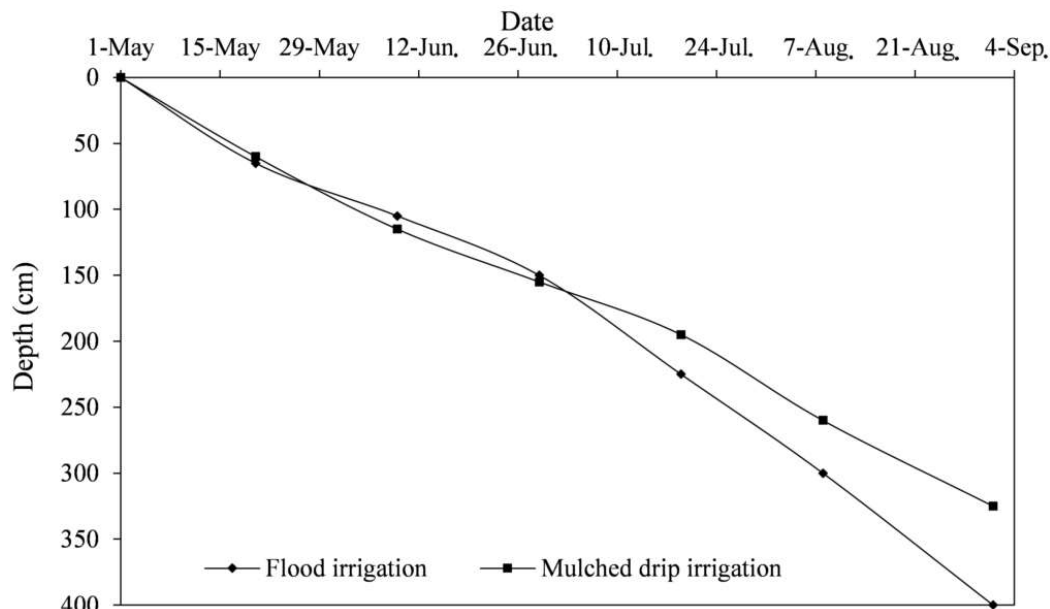
Figure 6. Infiltration depths at different times under mulched drip irrigation and flood